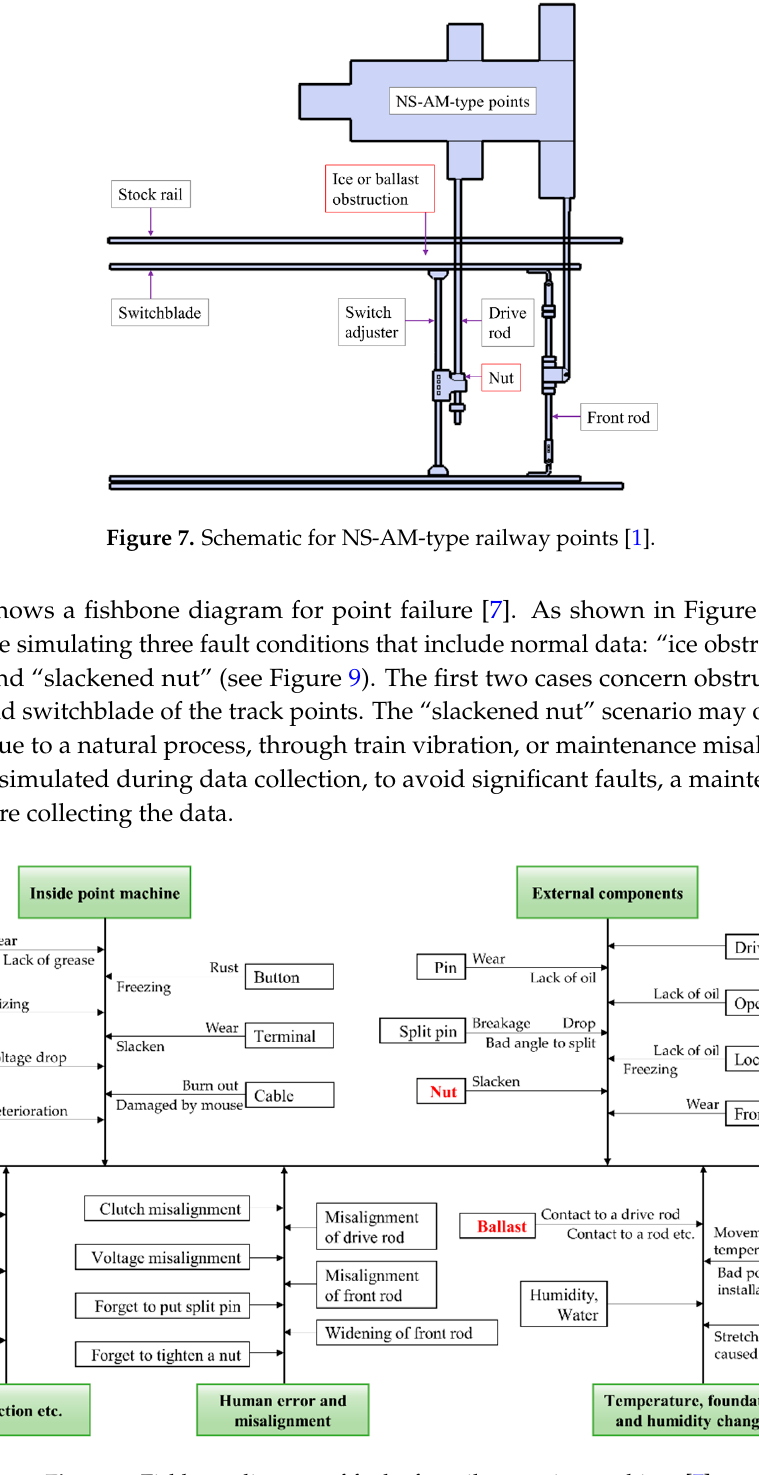
Figure 6. Data collection from NS-AM-type railway points.